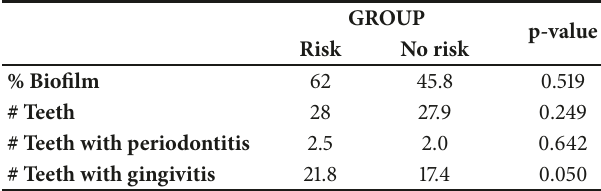
Table 1: Oral clinical characteristics by group.